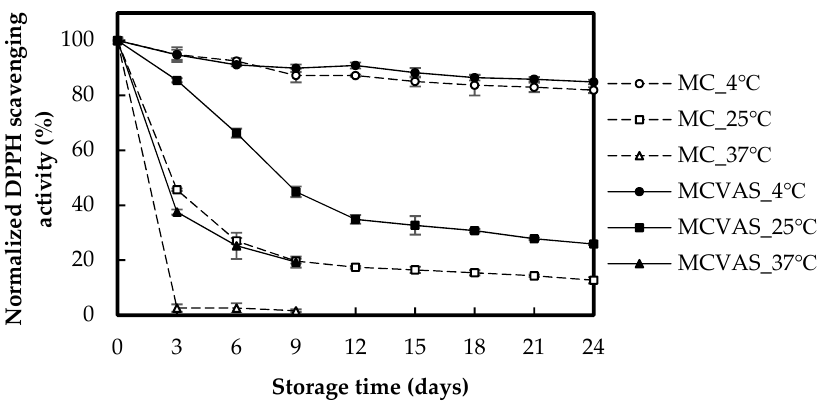
Figure 5. Effects of storage time on the normalized 1,1-diphenyl-2-picrylhydrazyl scavenging activity of Momordica charantia L. and Momordica charantia L. var. abbreviata Ser.